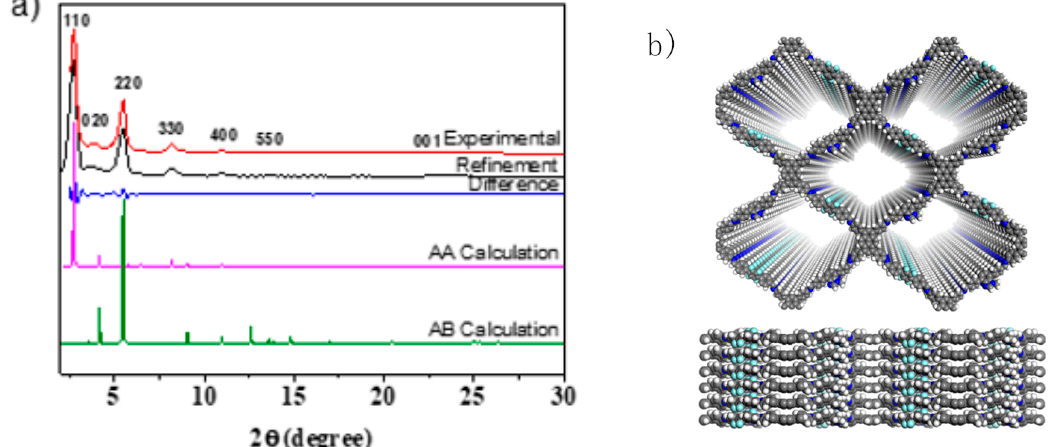
Figure 1. ( a ) PXRD patterns of IM4F-Py-COF. Observed XRD pattern (red) and profiles simulated using the Pawley refinement (black), their difference (blue), AA-stacking (magenta), and AB-stacking (olive) modes of the IM4F-Py-COF; ( b ) Schematic arrangement structure of